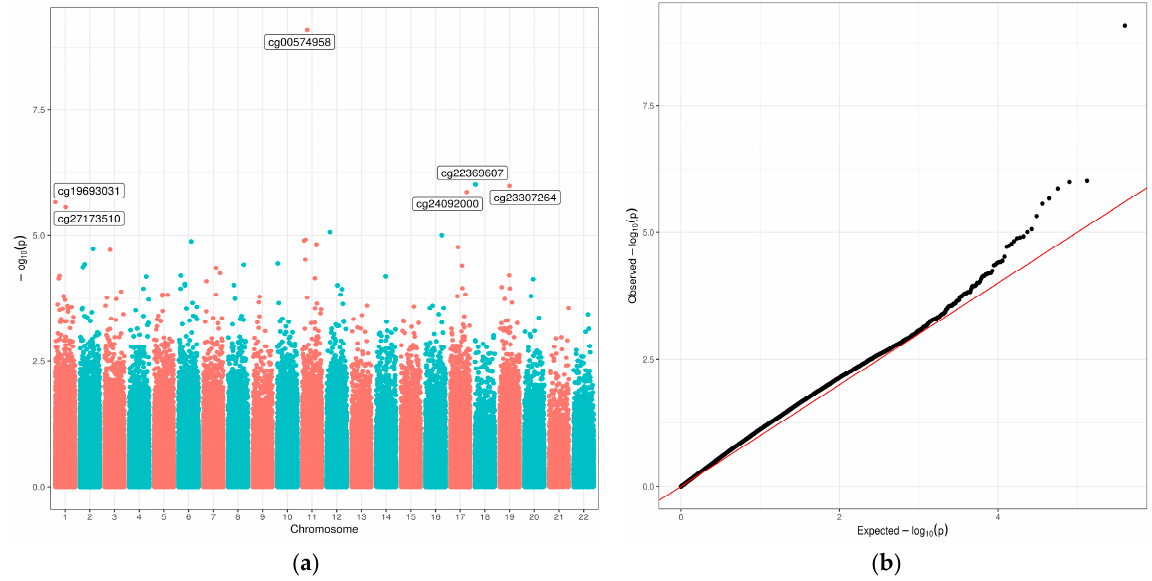
Figure 2. Manhattan plot ( a ) and Q-Q plot ( b ) for the epigenome-wide association study (EWAS) of breastfeeding duration in infancy (9–15 months). Breastfeeding duration was a continuous variable, in months. Models were adjusted for age at methylation measure, sex, race/ethnicity, cell composition, and platform. In the Manhattan plot ( a ), given names of six CpG sites indicate those that were associated with breastfeeding duration at FDR < 0.10. Table 3. Significant associations between infant diet and DNA methylation in infancy (9–15 months) in DAISY infants ( n = 243) from an epigenome-wide association study (EWAS) and analysis of candidate CpGs from the previous literature. Nearest Gene Position Gene Region